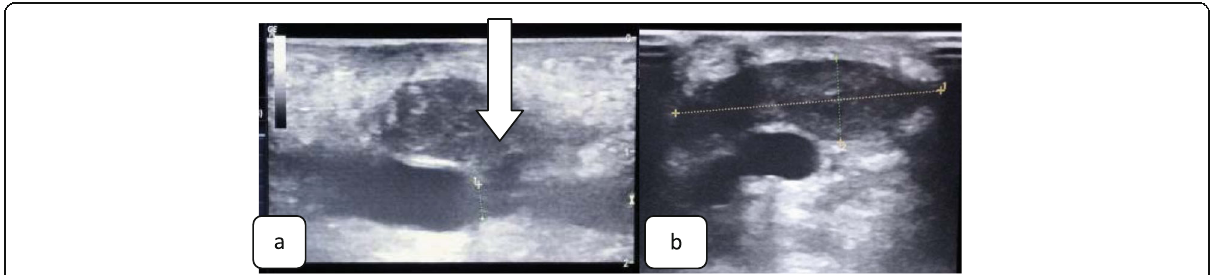
Fig. 2 Gray scale images show a hematoma at the puncture site, anterior to the venous side of AVF, a sagittal view shows site of puncture (arrowed) and vein lumen reduction by the mass effect of hematoma, b shows the site& dimensions of the